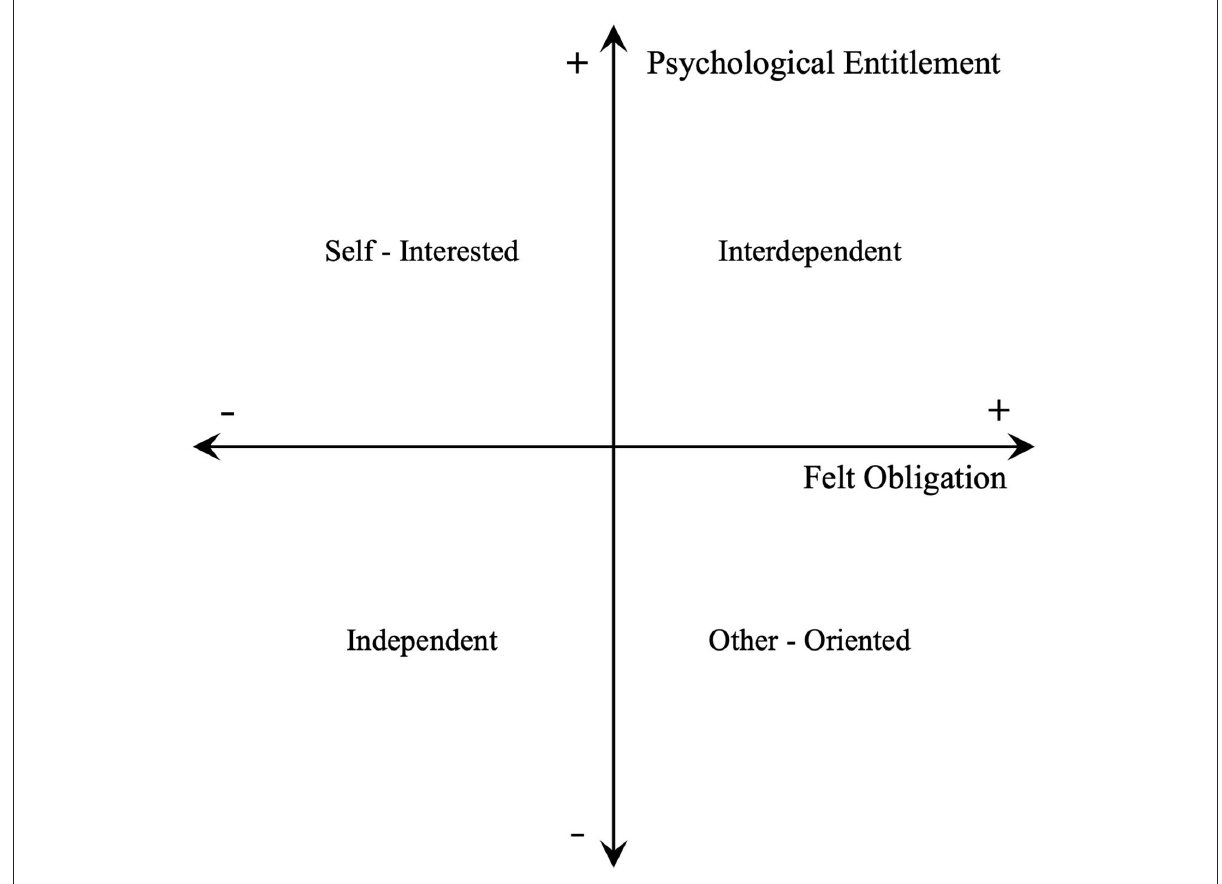
FIGURE1 Felt obligation and psychological entitlement social orientations.